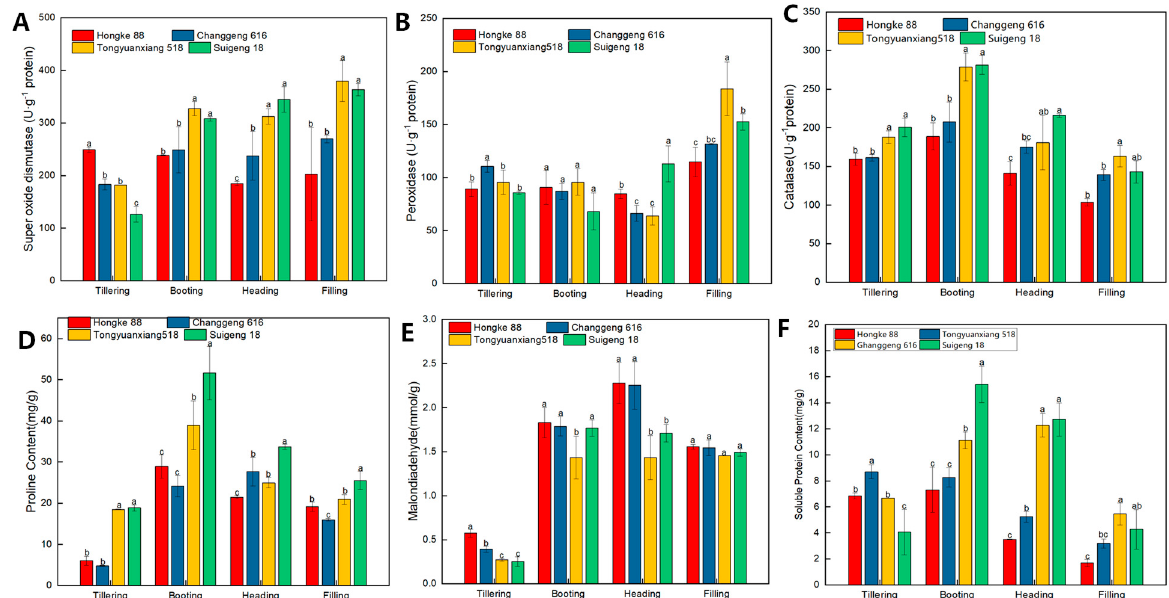
Figure 3. Changes in the physiological characteristics of different varieties of rice after under dry cultivation. SOD (superoxidase dismutas) ( A ), POD (Peroxidase) ( B ), CAT (catalyses) ( C ) activities. Proline ( D ), MDA (Malondialdehyde) ( E ) and soluble protein ( F ), Vertical bars represent the S.E. of the means (n = 3). Within each stage of an experiment, means bars marked by the same letters are not significantly different at p <